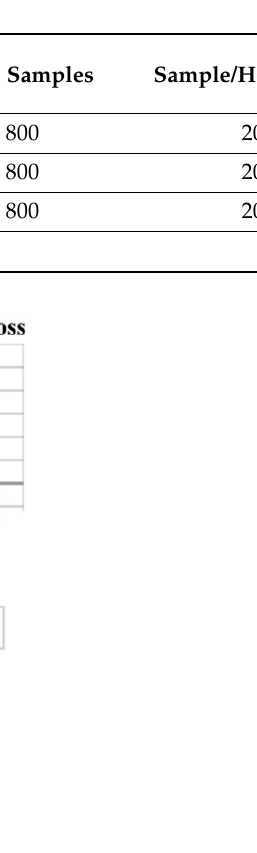
Figure 9. Loss functions: ( a ) training and validation loss for Task 1: speed detection, ( b ) training and validation loss for Task 2: health type identification, and ( c ) overall MTL-CNN model training and validation loss.